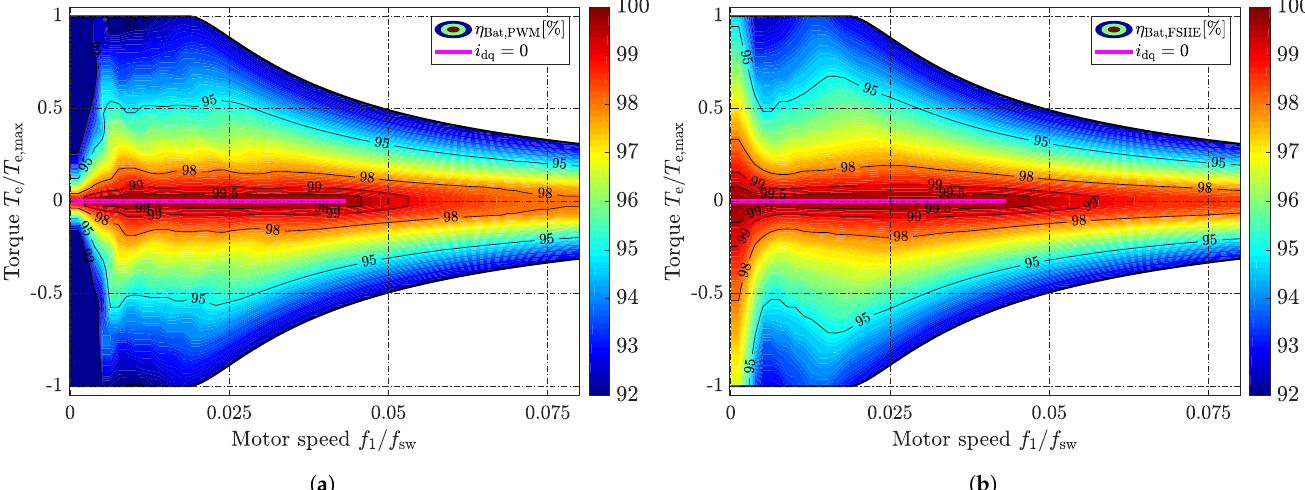
Figure 13. Simulated battery efficiency η Bat for the entire drivetrain operating range for ( a ) multilevel PWM and ( b )